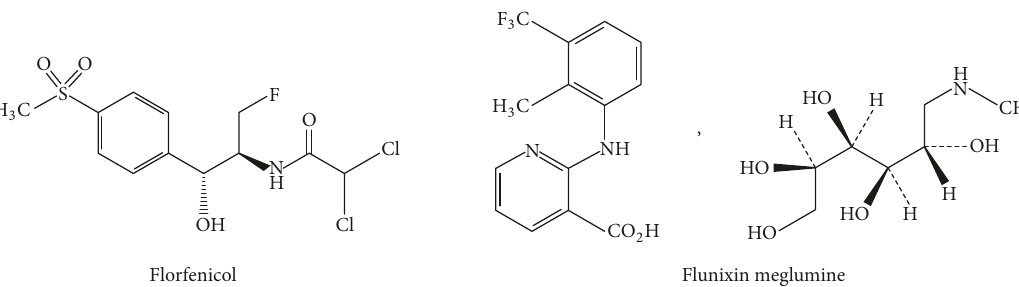
Figure 1: Chemical structure of florfenicol and flunixin meglumine.